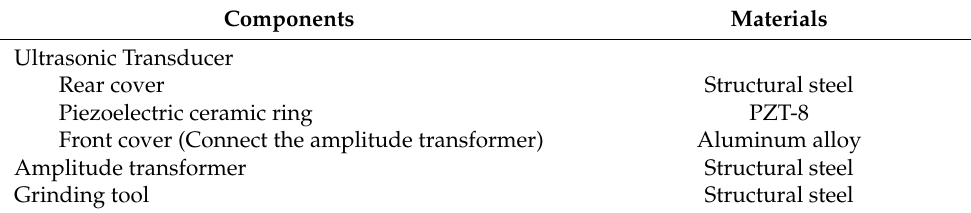
Table 1. Material setup for the ultrasonic vibration system in